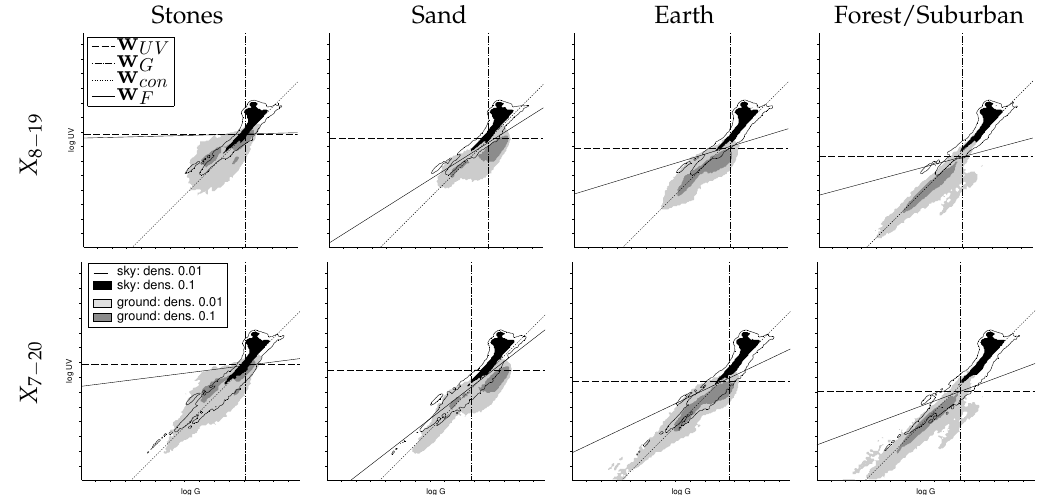
Figure 9. The columns show the log UV/G plots of the three mineral skylines (stones, sand, earth) and the skyline dominated by trees from the previous study (forest/suburban). Note that in each plot, the pooled sky data of all skyline databases are shown, representing a wide variety of weather conditions (the slightly different appearance is due to normalization). Each row shows the data recorded at day times between 8:00–19:00 and 7:00–20:00, respectively. The lines show the global linear separators that maximize the classification rate for each presented log UV/G dataset: w UV (UV-only), w G (green-only), w con (contrast: 1:1) and w F (contrast: Fisher discriminant). The classification rate of these separators can be found in Table 1. The black region and the black outline show the density level of the sky class for the levels 0.1 and 0.01 after transforming the point cloud into a continuous distribution by superimposing a Gaussian at each point ( σ = 1), respectively. Analogously, these levels are represented for the ground class by dark and light gray areas (Section 2.2). On each tick mark, the irradiance value is doubled, representing a ‘stop’ in camera